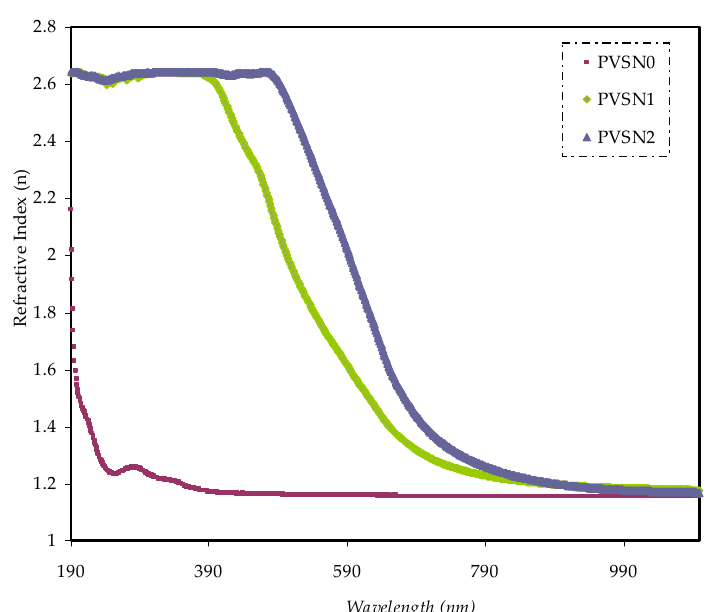
Figure 8. Refractive index spectra versus wavelength for PVA and loaded films.